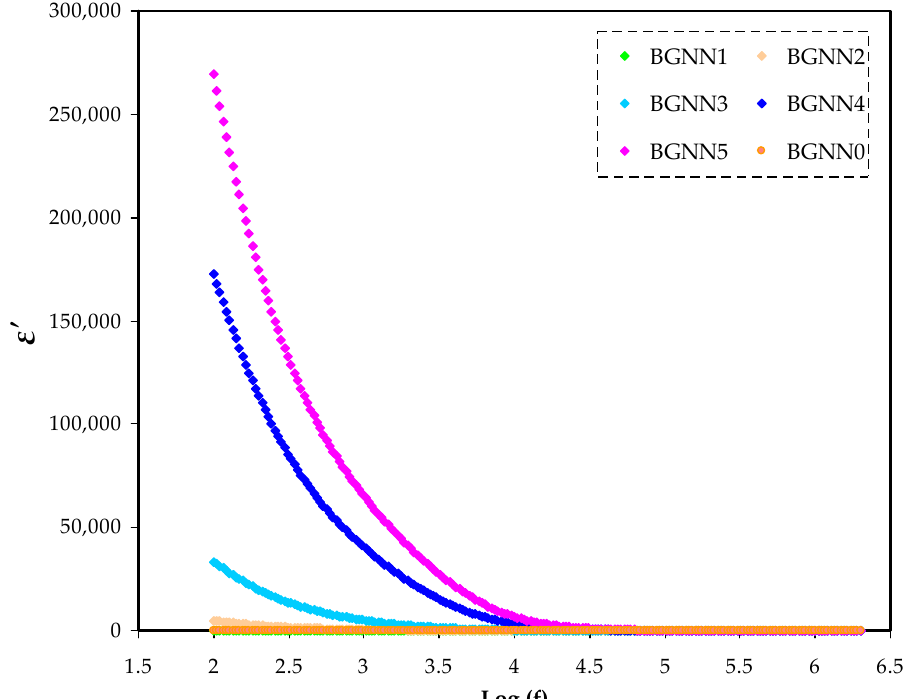
Figure 4. The E (cid:48) spectra for the NBG electrolyte Figure 4. the ɛ ’ spectra for the NBG electrolyte systems.